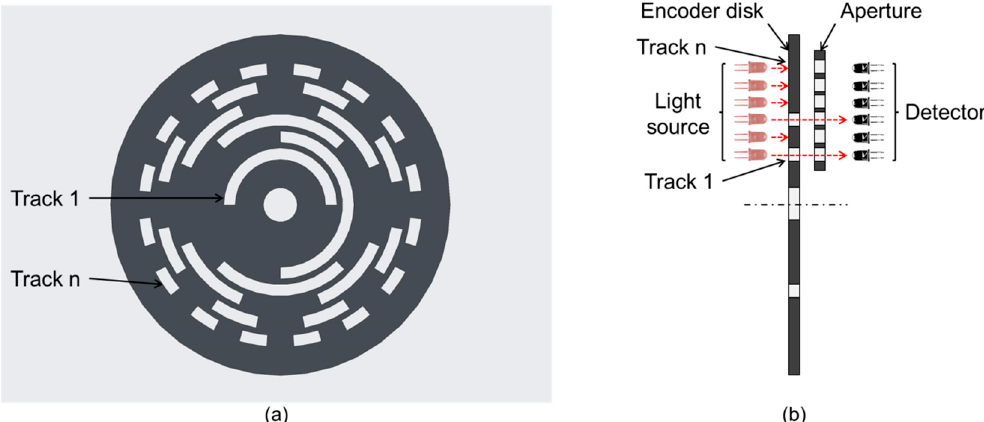
Figure 2. ( a ) Encoder disc of an absolute optical encoder with Gray code patterns of opaque and transparent parts; ( b ) cross-section of the optical path.